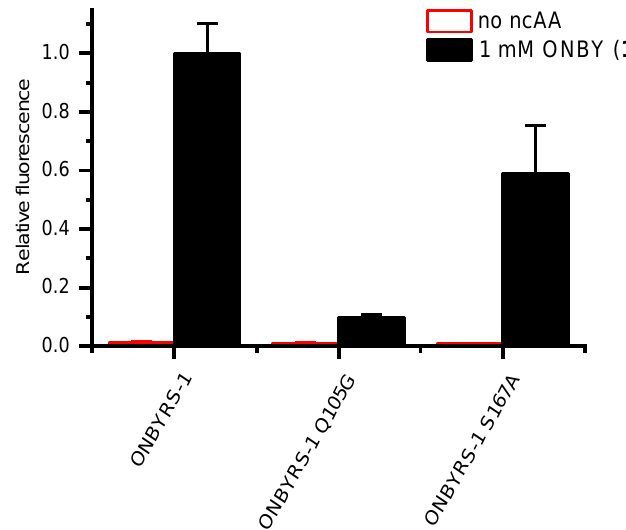
Figure 6. In-cell fluorescence measurements of construct sfGFP(1TAG) expressed in parallel to orthogonal translation systems with ONBYRS-1 and two aaRS mutants, respectively. Fluorescence values were normalized to the OD 600 of the bacterial E. coli BL21(DE3) cultures. Data represent mean ± s.d. of biological triplicates.